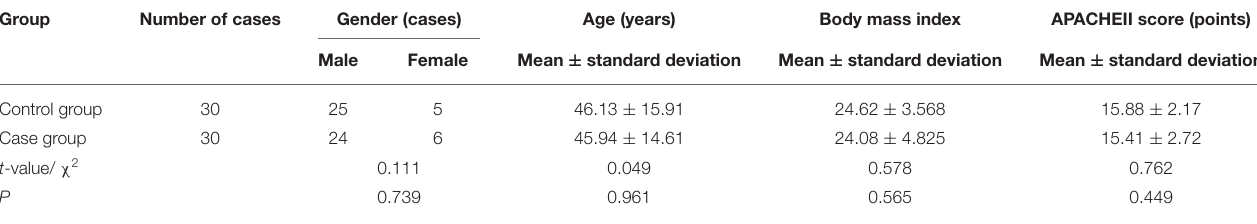
TABLE 2 | Comparison of general information of the two groups of patients.